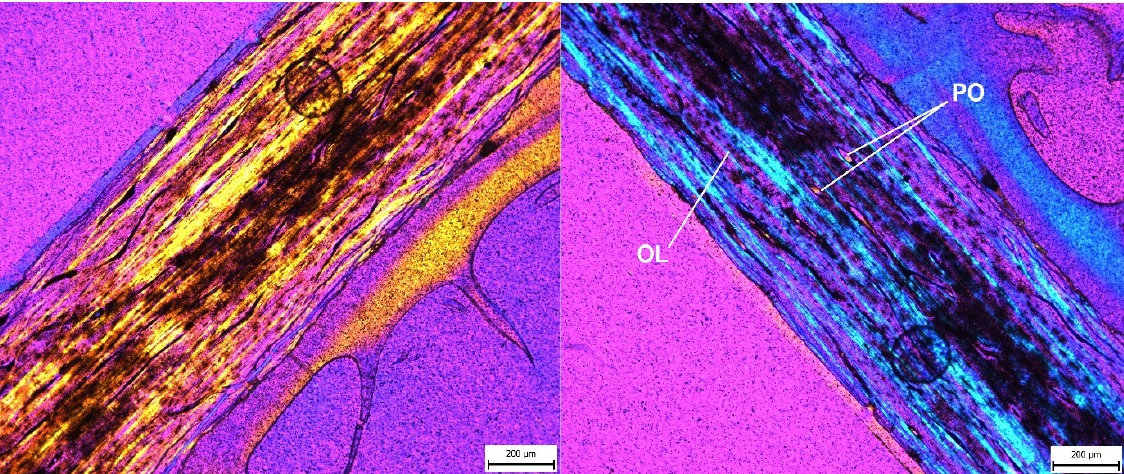
Figure 11. Thin section of MGUAN-PA653 ulna fragment under crossed polarized light and rotated under a lambda filter. Abbreviations: OL, osteocyte lacuna; PO, primary osteon.